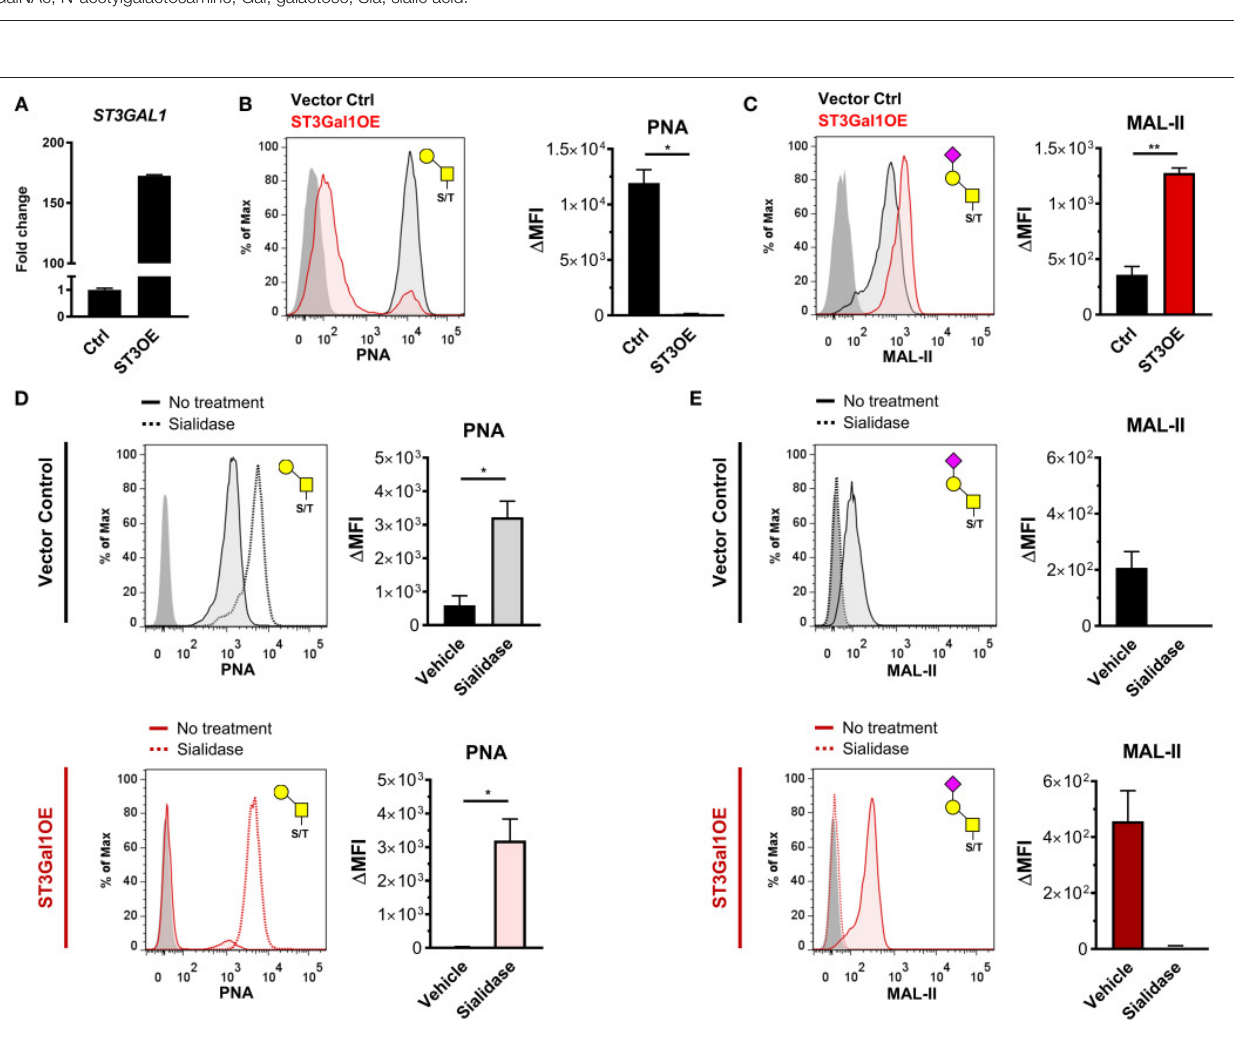
FIGURE 2 | ST3Gal1 regulates PNA binding in B cells by sialylating Core 1 O-glycans. (A) Validation of ST3GAL1 overexpression in Ramos B cells by qRT-PCR. Data were normalized to housekeeping control VCP and presented relative to vector control. (B) Representative histogram ( left ) and quantification ( right ) of flow cytometric analysis of PNA binding to vector control and ST3Gal1OE Ramos B cells. The Core 1 O-glycan/ T-antigen specificity of PNA is depicted at top right. (C) Representative histogram ( left ) and quantification ( right ) of flow cytometric analysis of MAL-II plant lectin binding to vector control and ST3Gal1OE Ramos B cells. The α 2,3-sialylated Core 1 O-glycan/sialylated T-antigen glycan favored by MAL-II lectin is depicted at top right. (D) Representative histogram ( left ) and quantification ( right ) of PNA binding to vector control ( top ) or ST3Gal1OE Ramos B cells ( bottom) before and after removal of sialic acids by intact cell treatment with Arthrobacter ureafaciens sialidase. (E) Representative histogram ( left ) and quantification ( right ) of MAL-II binding to vector control ( top ) or ST3Gal1OE ( bottom) Ramos B cells before and after sialidase treatment, as in (D) . Data in (B–E) are from three independent experiments with three biological replicates in total. Statistics were calculated using Welch’s unpaired, two-tailed t -test (B–E) . Throughout, bars and error bars depict the mean and SEM, respectively. ns = not significant, * p ≤ 0.05, ** p < 0.01, 1 MFI, background subtracted geometric mean fluorescence intensity; Ctrl, vector control. ST3OE; ST3Gal1 overexpression.